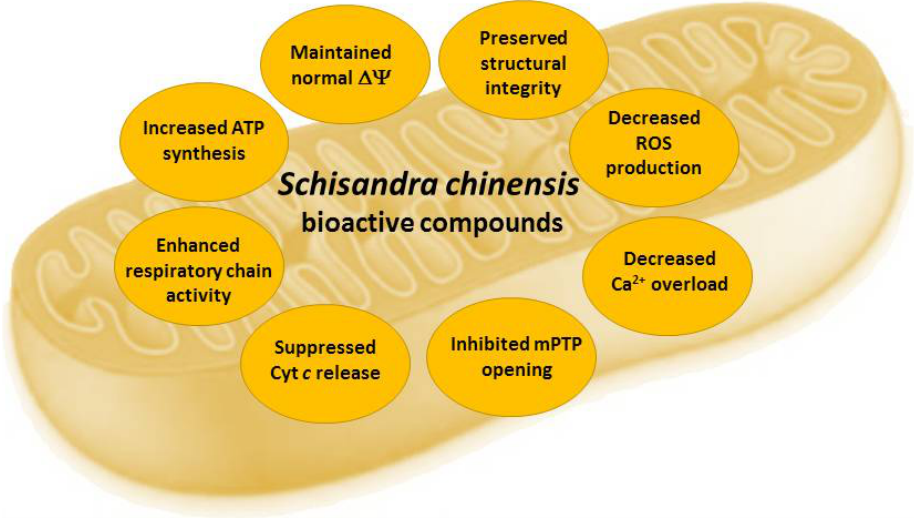
Figure 4. Effects of Schisandra chinensis fruit extracts and their bioactive compounds in mitochondria. ∆Ψ —mitochondrial membrane potential, mPTP—mitochondrial permeability transition pore, ROS—reactive oxygen species.